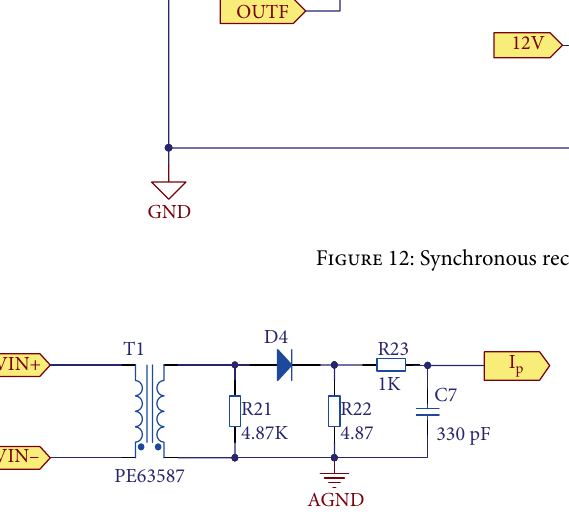
Figure 13: Transformer primary current sampling